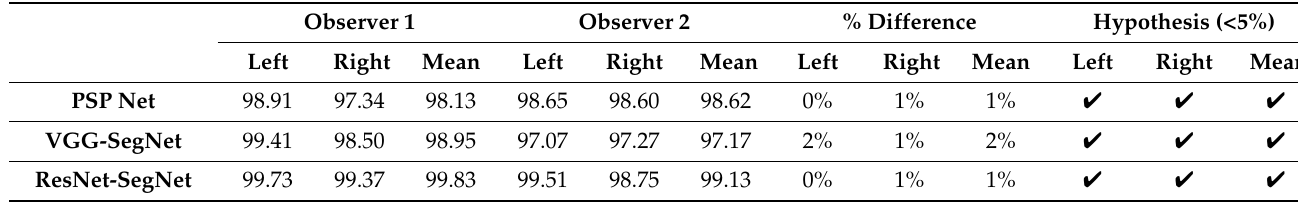
Table 5. FoM for lung long